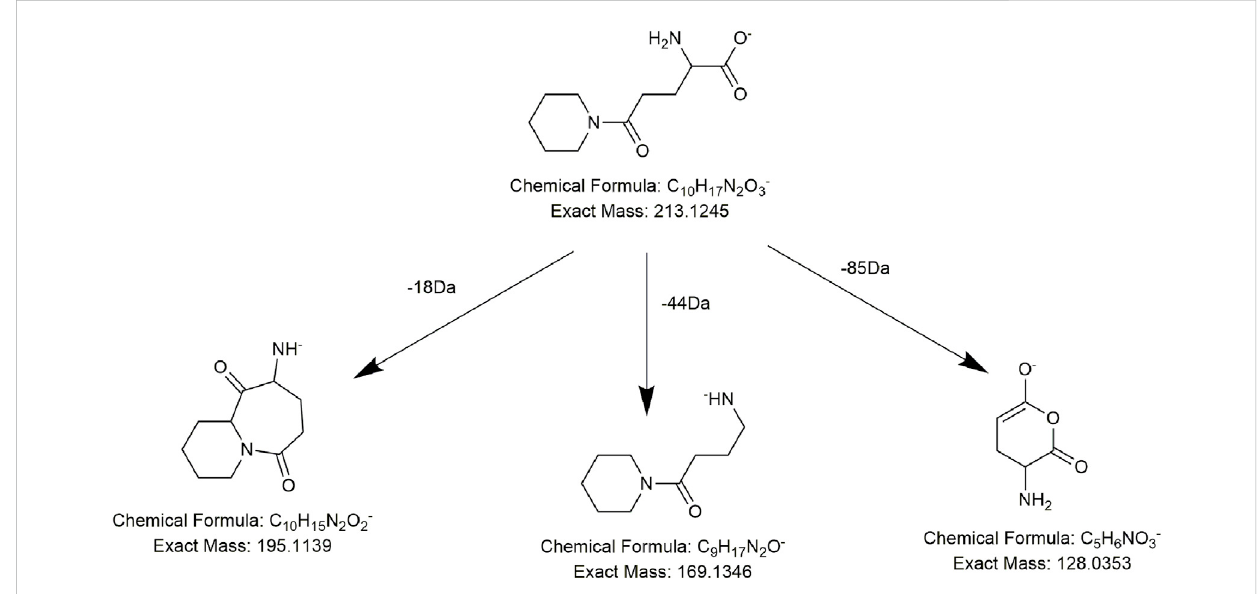
FIGURE 12 Proposed fragmentation pathways of AM9 (1-piperidinepentanoic acid, α -amino- δ -oxo-,